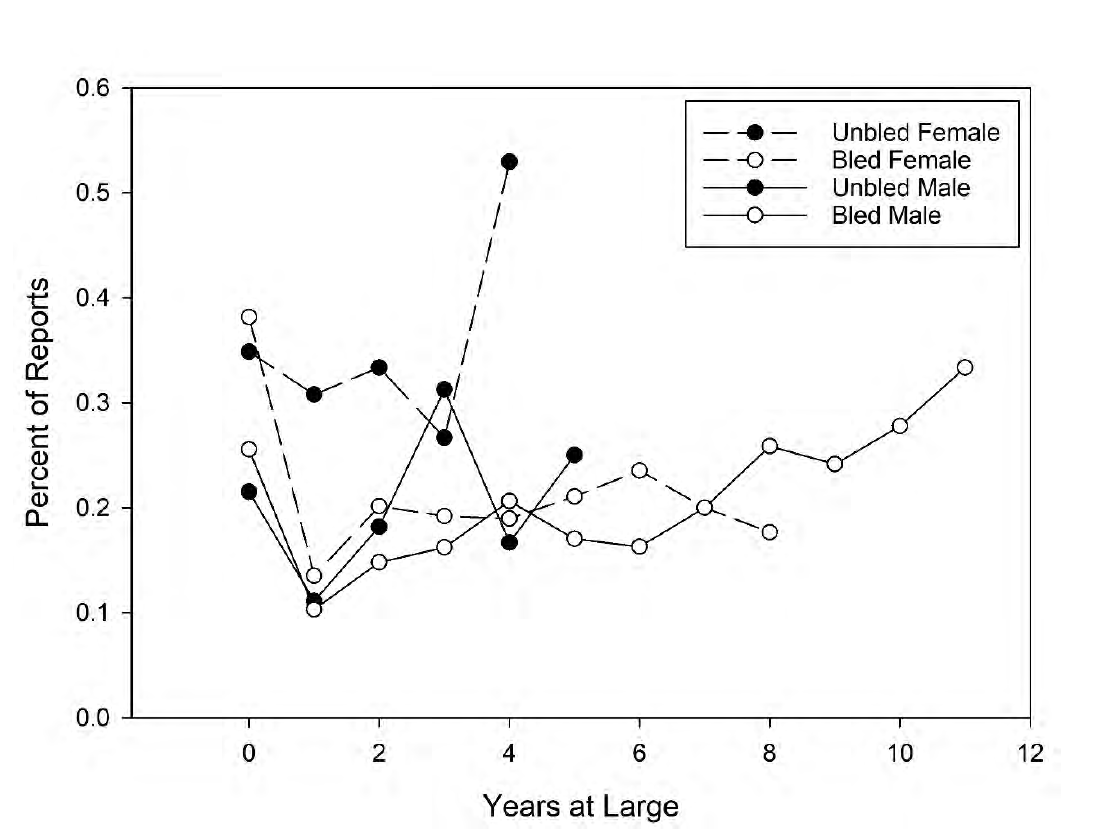
Figure 8. Comparison of bled (open circles) and unbled (filled circles) male (solid line) and female (dashed line) horseshoe crabs recaptured as dead over